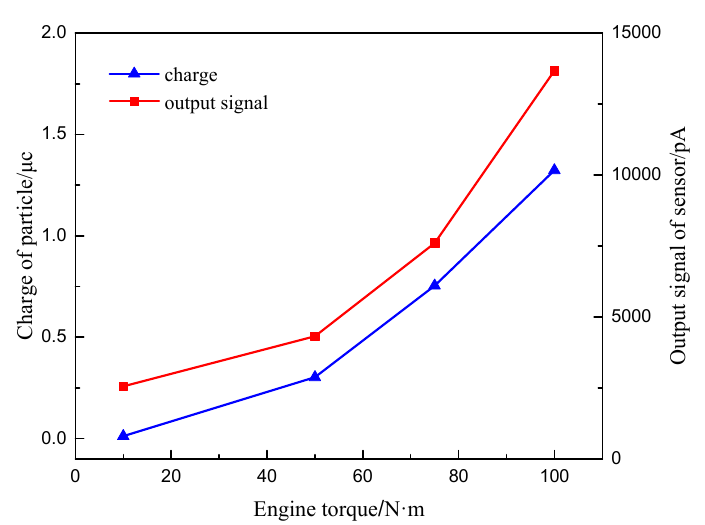
Figure 16. The law of charge of particles and output signal of sensor changing with di ff erent engine torque.